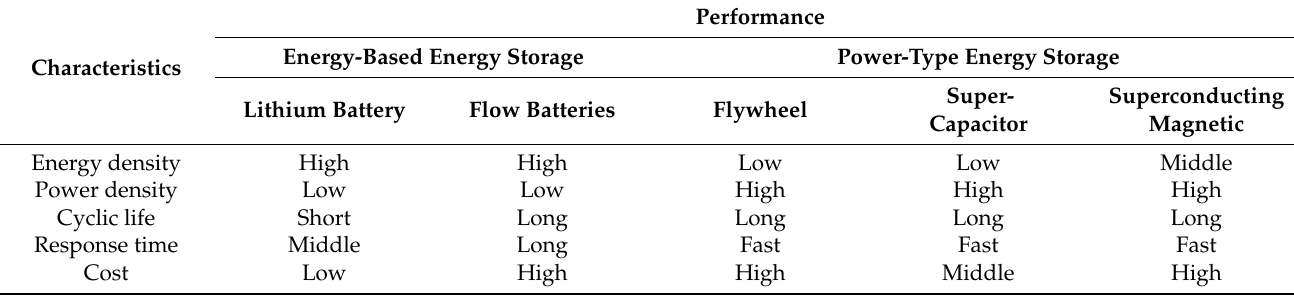
Table 1. Performance comparison of energy storage